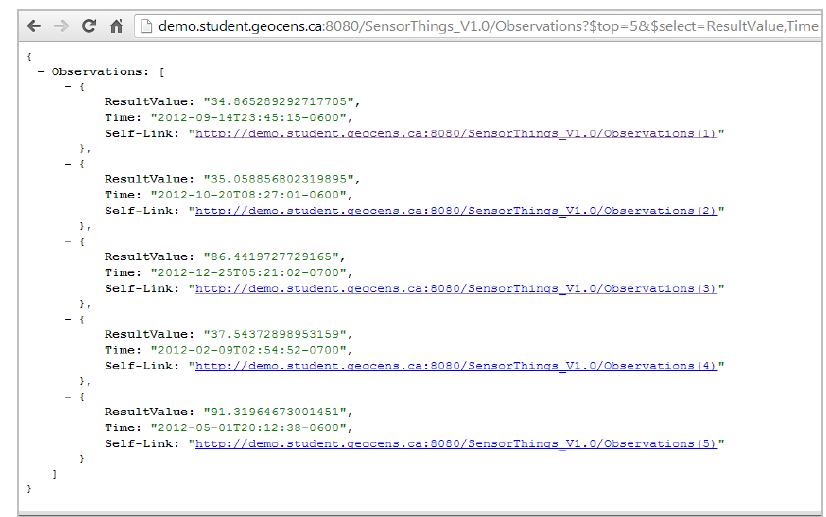
Figure A7. Summarized response of the SensorThings.